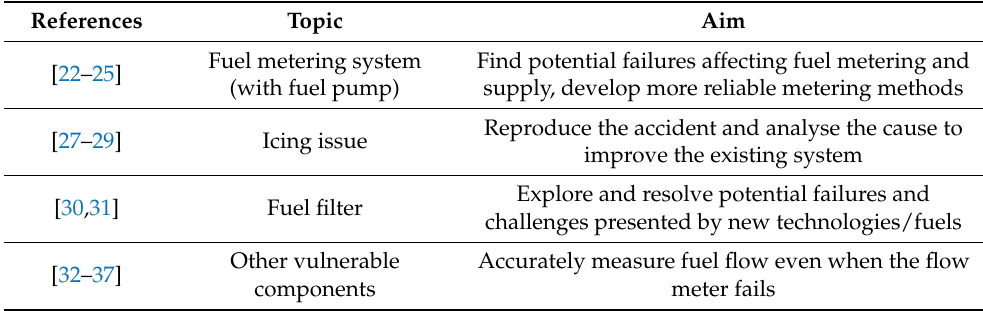
Table 1. Experimental work for the most vulnerable components in the fuel